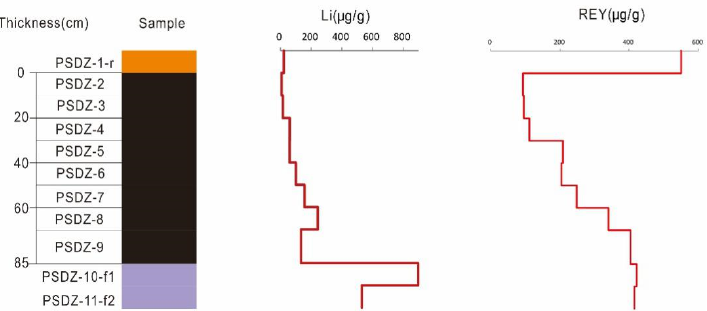
Figure 4. Variations of Li and REY (rare earth elements and yttrium) concentrations along coal seam profiles in the Donggou mine.